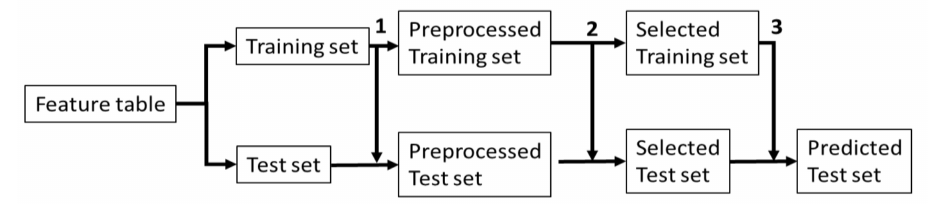
Figure 2. Schematic representation of cross-validation procedure. First, the data were divided into a training set and a test set. ( 1 ) Preprocessing of data using parameters derived from the training set such as mean and k neighbors. ( 2 ) Inner cross-validation based on the training set to select variables and number of (orthogonal) latent variables using DQ 2 . ( 3 ) PLS-DA model based on the variable selected training set and used to predict the test set. Based on the predicted test set, an accuracy was